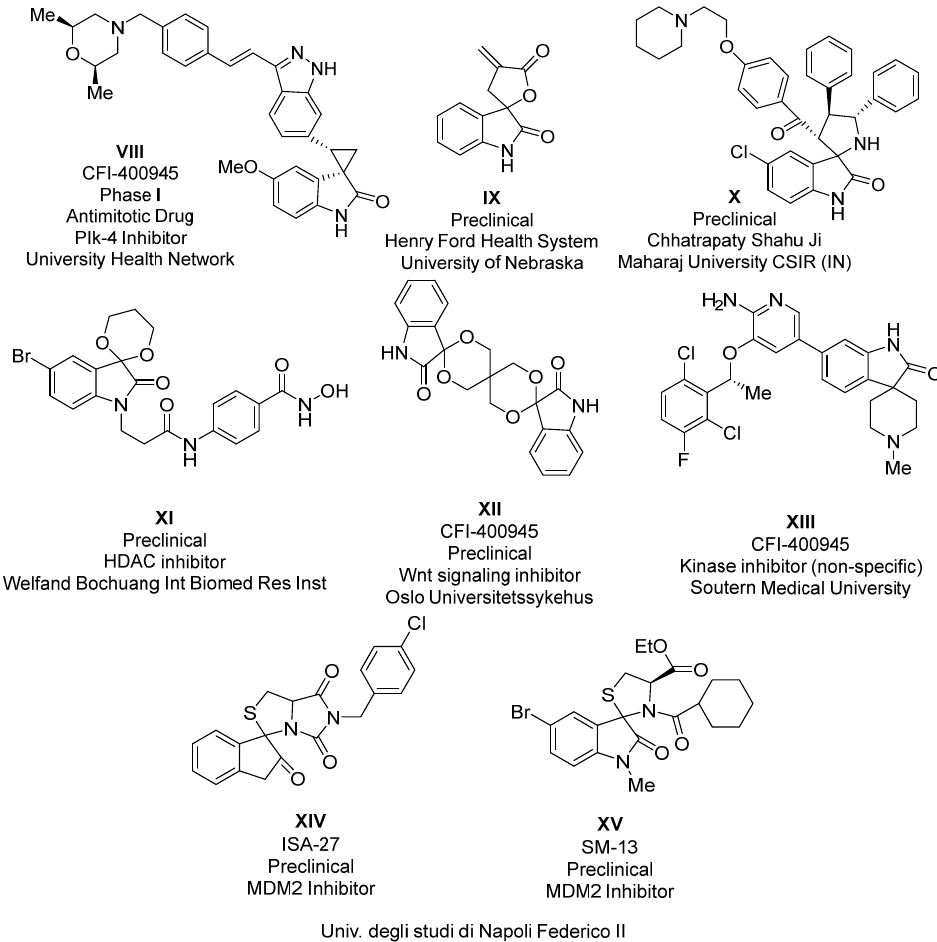
Figure 2. Representative examples of spiro -indolinones with anticancer activity.